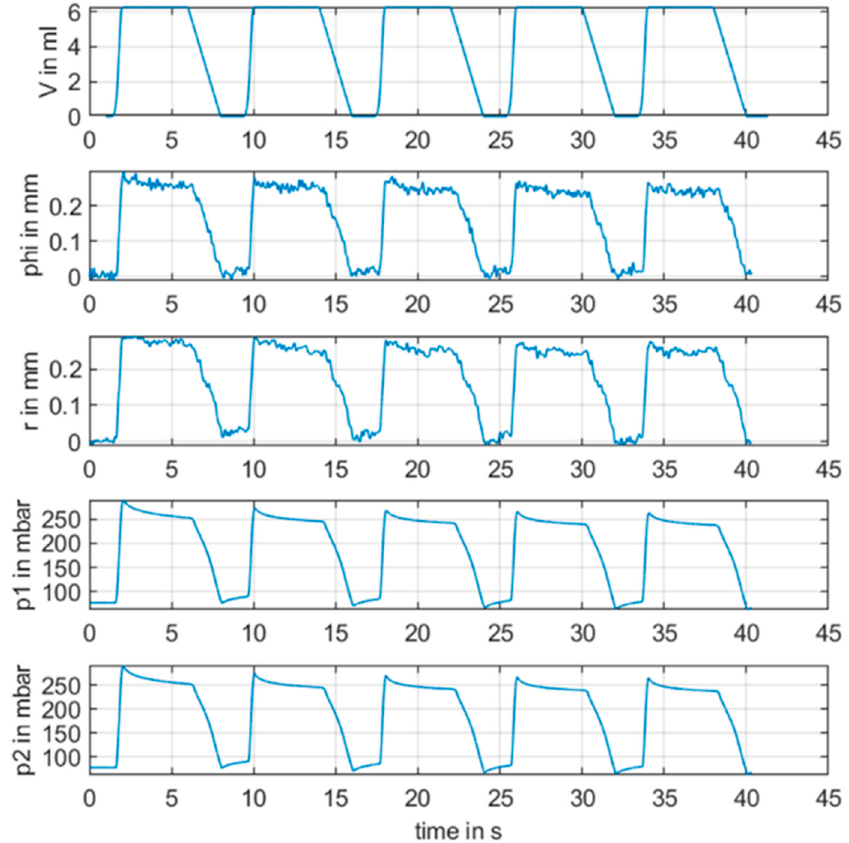
Figure 10. Comparison of measurements from all sensors. Phi is φ m [ mm ] from RF continuous wave radar measurements (CW) with a frequency of 4.1 GHz, p1 and p2 are the pressure sensors, r is the distance sensor, and V is the injected volume over time.